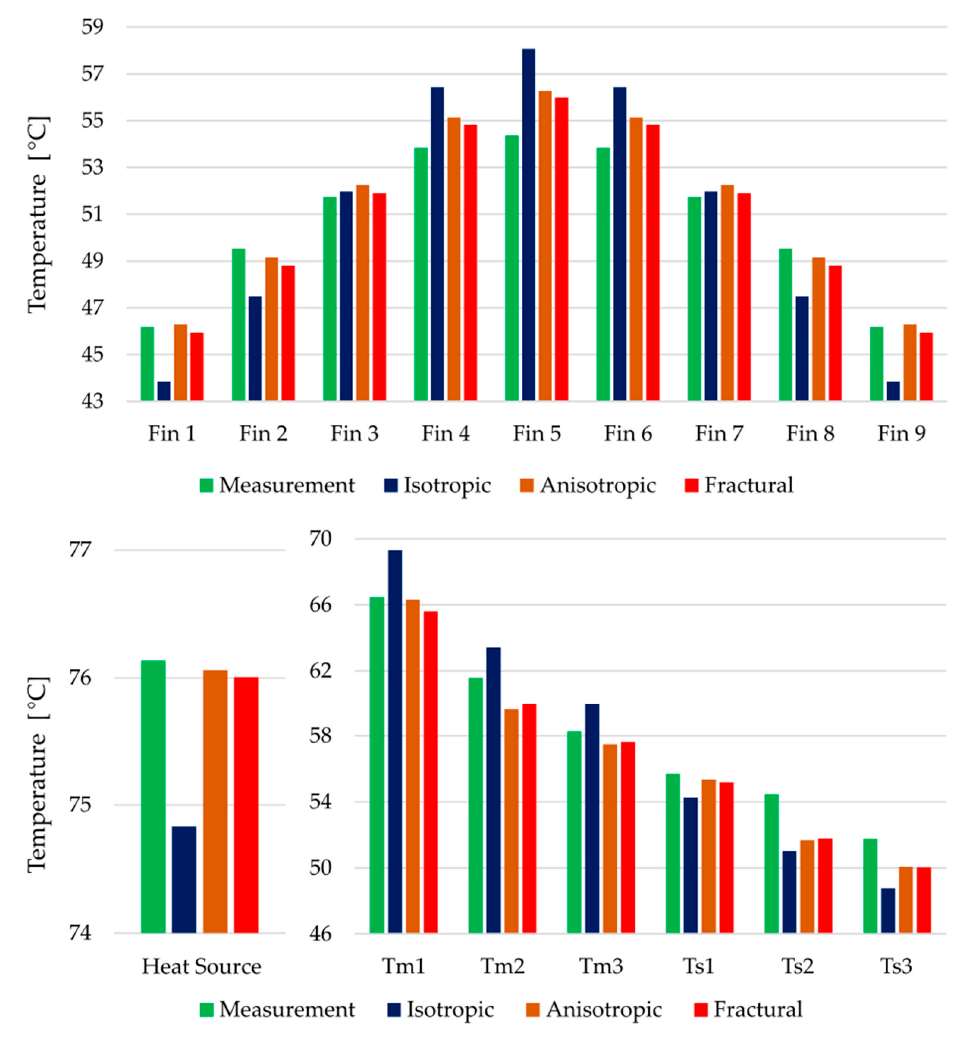
Figure 14. Measured and simulated temperatures of the three thermal conductivity approaches.